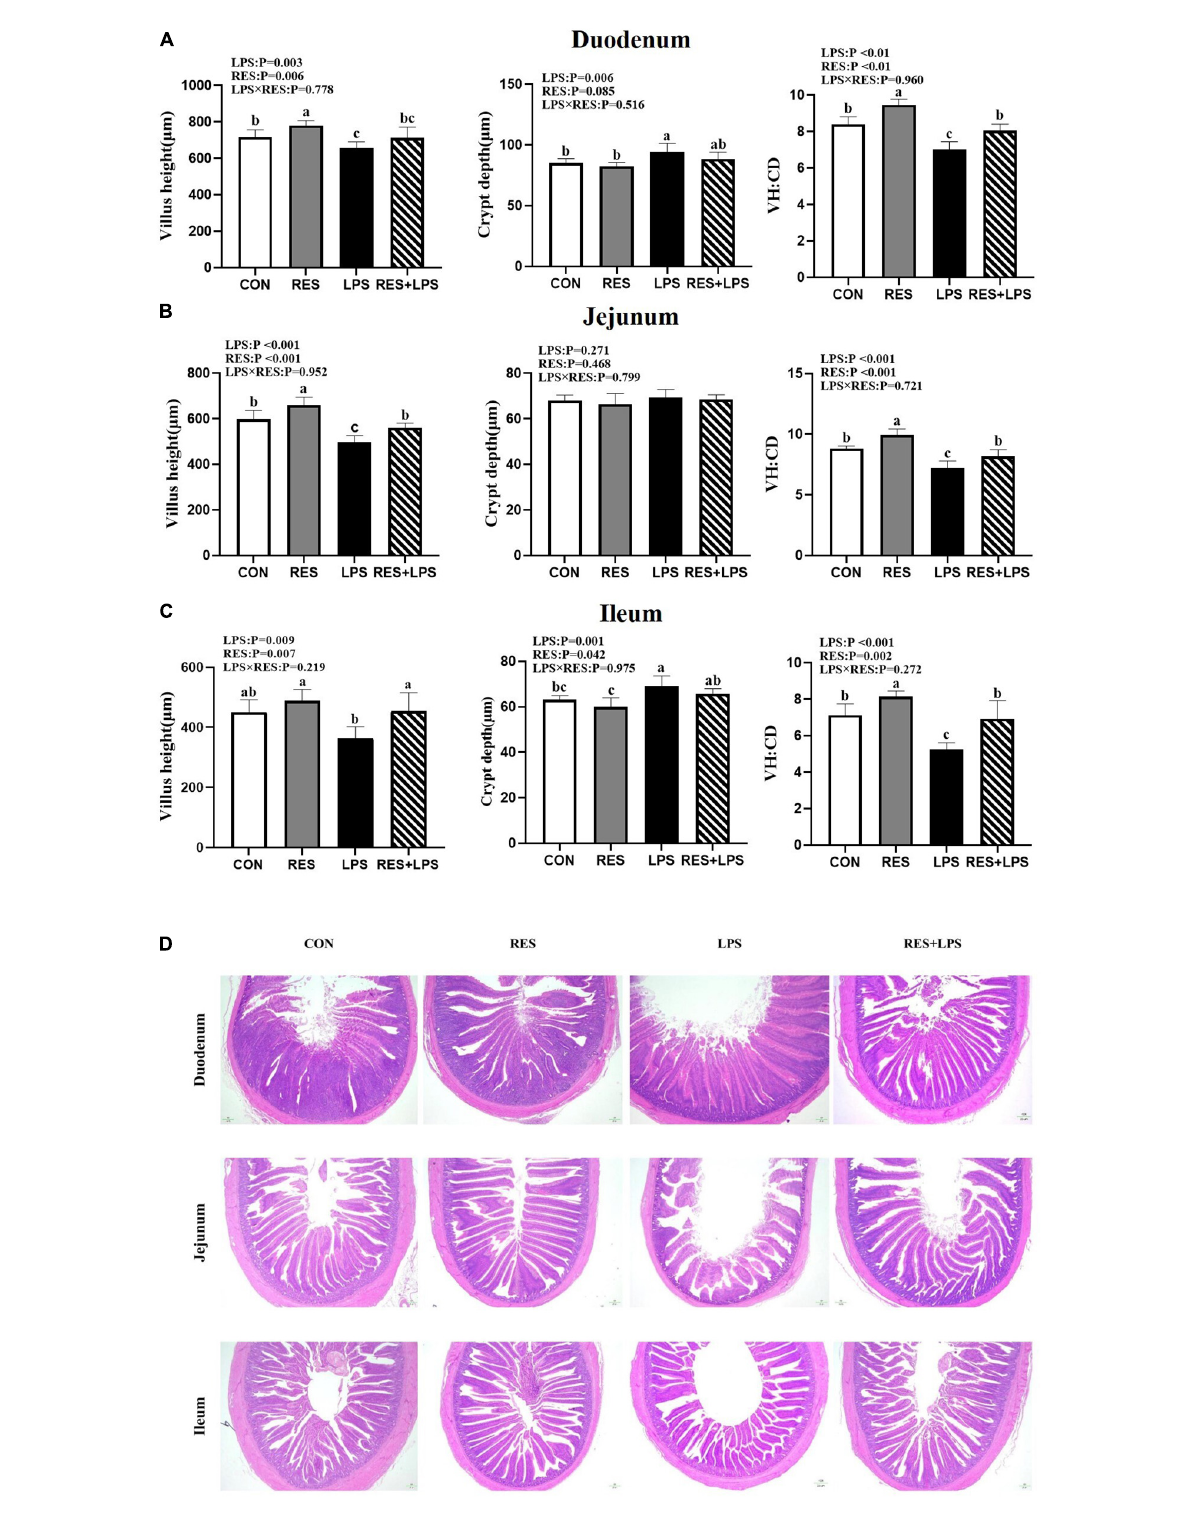
FIGURE1 Effect of dietary resveratrol supplementation on intestinal morphology in yellow-feathered broilers with lipopolysaccharide. (A) Duodenum. (B) Jejunum. (C) Ileum. (D) The represent images of HE staining. Original magnification 40 × , scale bar 20 µ m. Values are means and standard error of the means, n = 5 per treatment. abc Means in the columns with different superscripts differ ( P < 0.05). CON, control; RES, resveratrol; LPS, lipopolysaccharide; RES + LPS, dietary resveratrol treatment followed by LPS